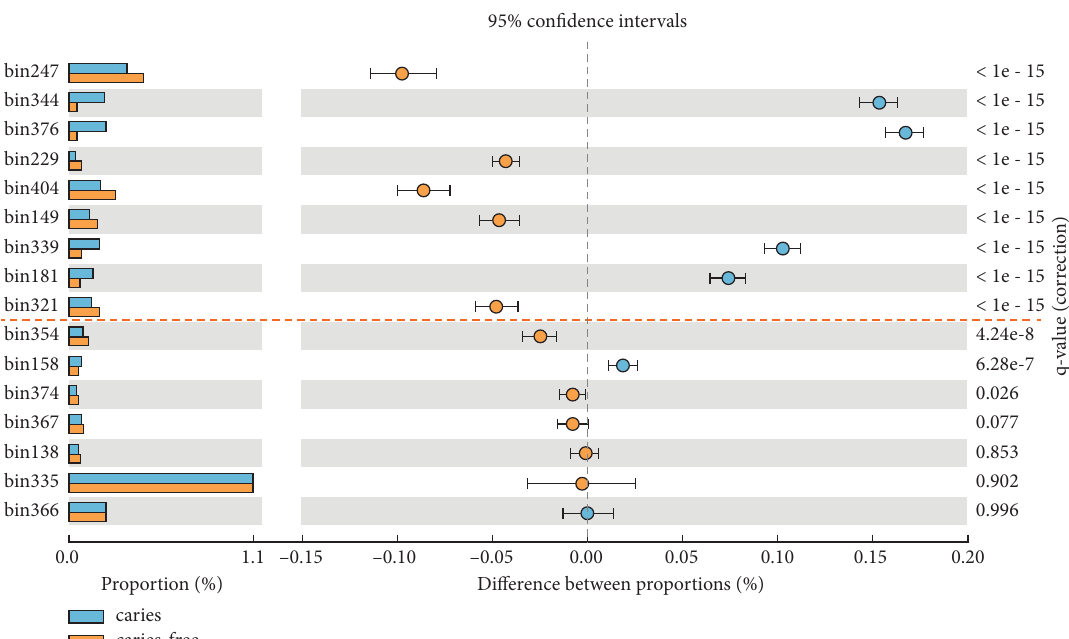
Figure 2: Comparison of relative abundance of each CPR MAGs between caries and caries-free groups. CPR MAGs above the dotted line are considered to be significantly